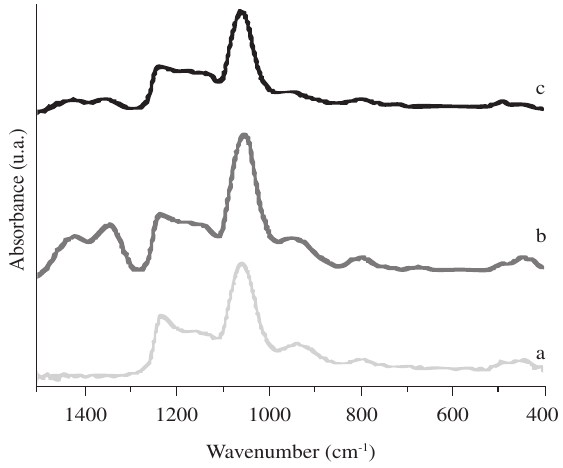
Figure 2. FTIR spectra of a) unary film; b) binary film; c) ternary film at 200 °C for 15 minutes at 25° of